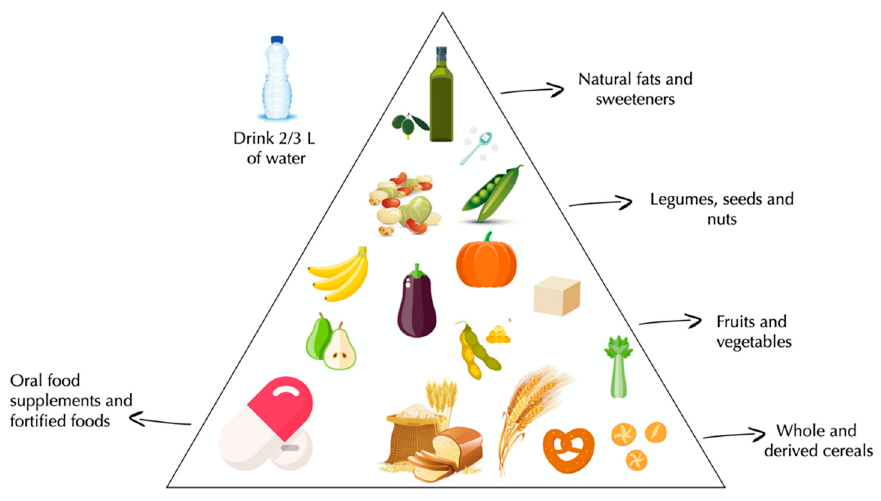
Figure 3. Vegan pyramid.